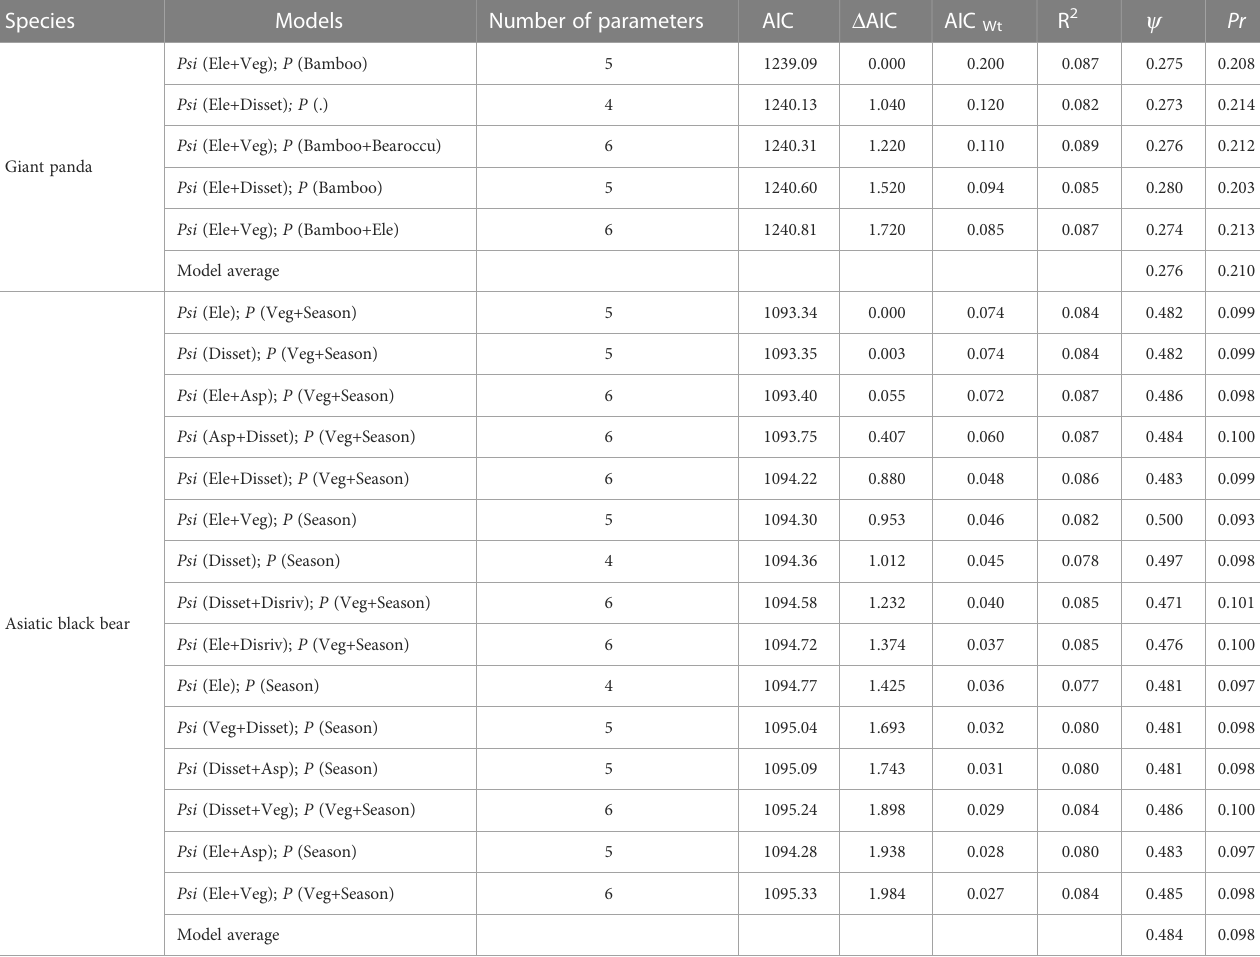
TABLE 1 Summary of model selection results for giant panda and Asiatic black bear occupancy in Changqing National Nature Reserve in the Qinling mountains, showing estimated occupancy rate and detection probability for the optimal models ( D AIC ≤ 2). Species